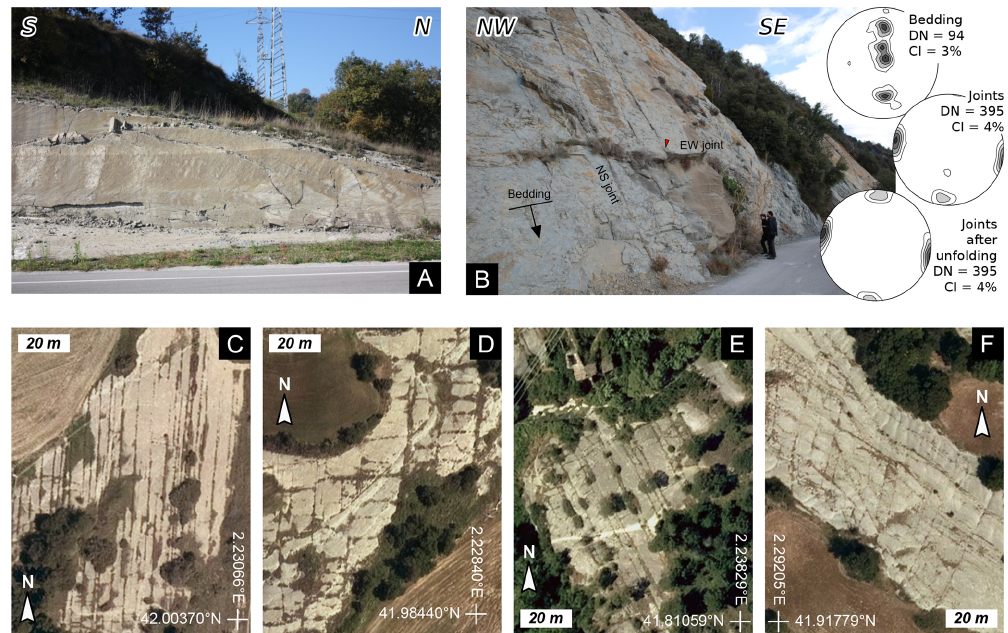
Figure 2. Examples of pre-folding joints within the studied area. (a) N–S striking joint with plumose structures in the foredeep sediments (42 ◦ 02 (cid:48) 39.7 (cid:48)(cid:48) N, 2 ◦ 13 (cid:48) 54.9 (cid:48)(cid:48) E). (b) Tilted N–S and E–W striking joints in the southern limb of the Bellmunt anticline, with the red arrow indicating an E–W striking joint abutting on a N–S striking joint (42 ◦ 05 (cid:48) 39 (cid:48)(cid:48) N, 2 ◦ 17 (cid:48) 41.5 (cid:48)(cid:48) E). The density contours of poles to bedding and joints (in their present-day orientation and after unfolding) refer to data collected in the Bellmunt anticline area. (c–f) Examples of joints seen in orthophotos. (c) Transverse joints. (d) N–S striking transverse joints with subordinate E–W striking cross-orthogonal joints. (e) NW–SE striking joints. (f) Rare example of multiple oblique sets occurring at the same exposure. The orthophotos in this figure are available from the Spanish Instituto Geográfico Nacional (https://pnoa.ign.es/, last access: 1 July